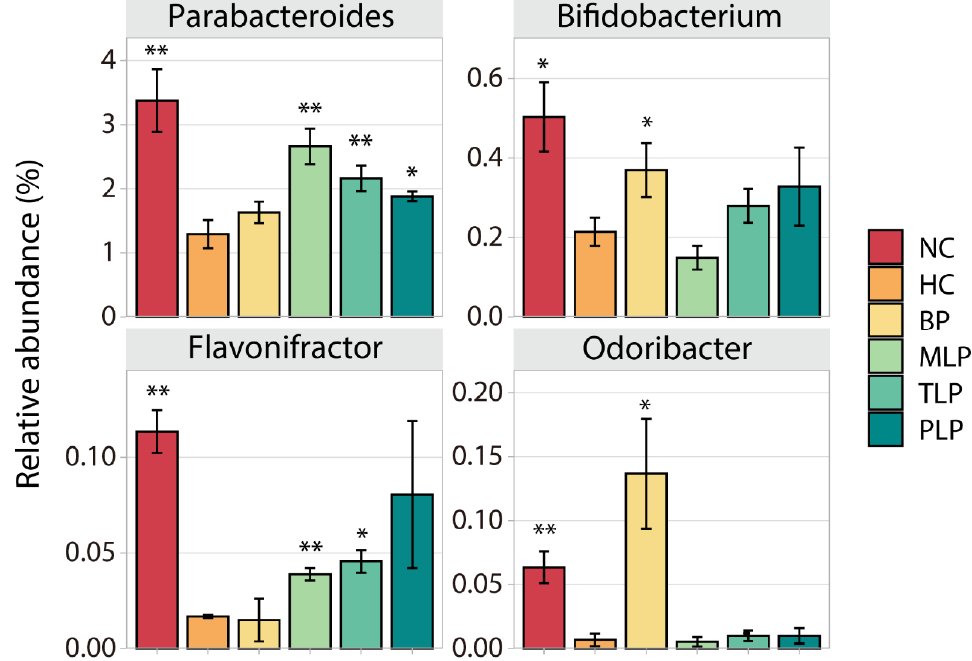
Figure 3. Changes in the content of four special bacteria in different groups after 48 h of fermentation in vitro. Differences in the HC group were assessed using Student’s t test and are denoted as follows: * p < 0.05, ** p < 0.01. NC: the feces of the healthy population were inoculated in FAM; HC: the feces of hyperlipidemic people were inoculated in FAM; BP, MLP, TLP, PLP: the feces of hyperlipidemic people were inoculated in FAMs with 0.5% of BP, MLP, TLP, and PLP. All experiments were repeated in triplicate (n = 3).